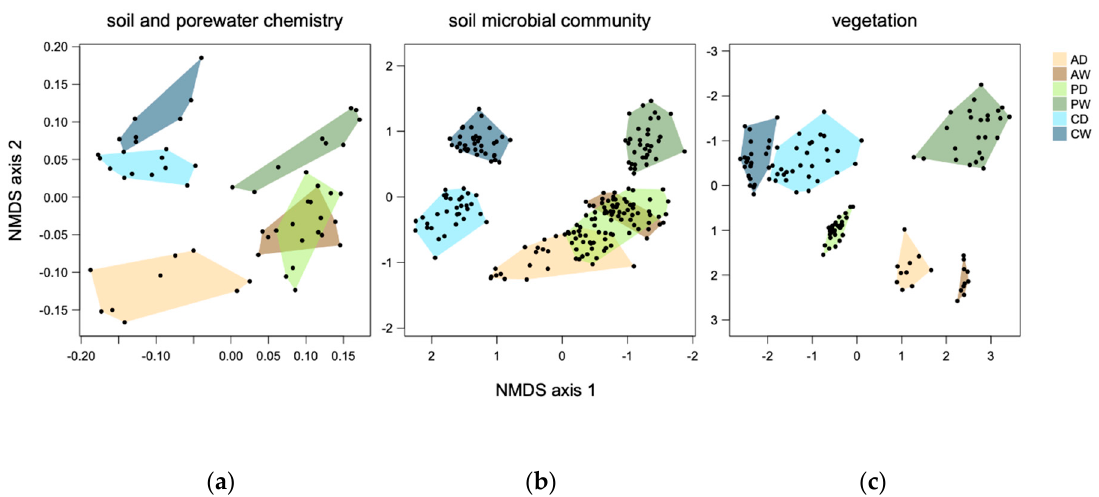
Figure 7. NMDS ordinations based on different data sets. See methods for included variables. All NMDSs had comparatively low stress (a: 0.12, b: 0.10, c: 0.05) and axes directions have been changed for soil microbial community on axis 1 and for vegetation on axis 2 to allow for easier comparison of patterns.